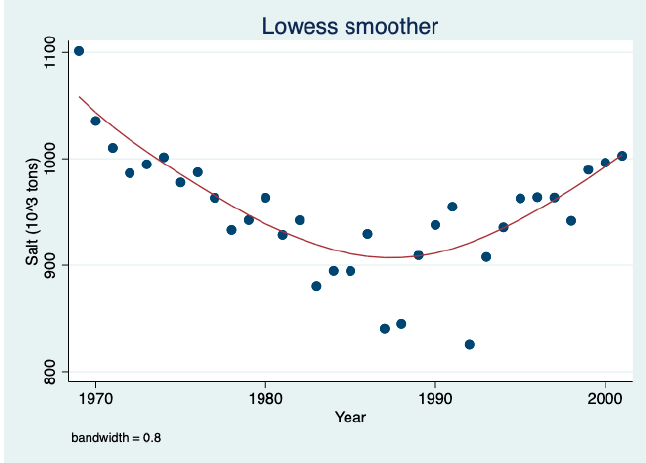
Figure 6. Similar computation of salt load and annual means of WL and lake volume was applied for Figure 6 where annual maximal values and means of salinity (ppm) and WL (mbsl) and lake volume (mcm) were plotted vs. time (1969–2001).